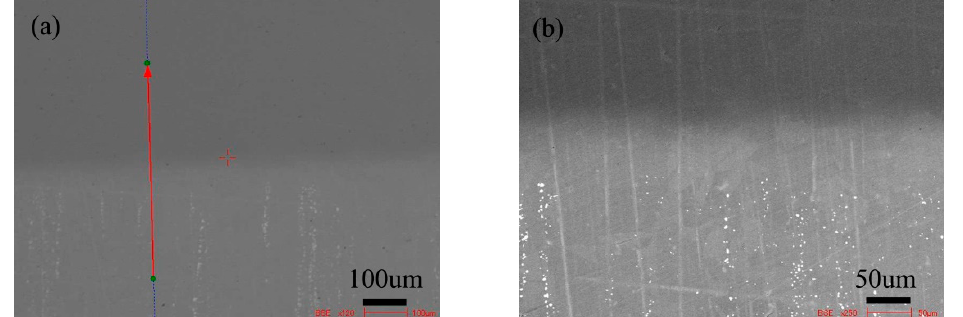
Figure 11. Microstructure of diffusion couple sample after 1000 °C/200 h heat treatment: ( a ) composition line scan position of the sample and the upper side is pure nickel material and lower side is 0Si alloy, ( b ) the enlarged view of map a.